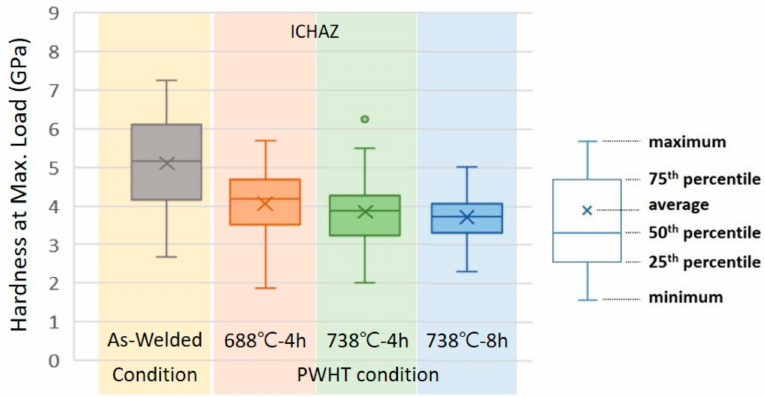
Figure 10. Hardness variation in the ICHAZ measured by